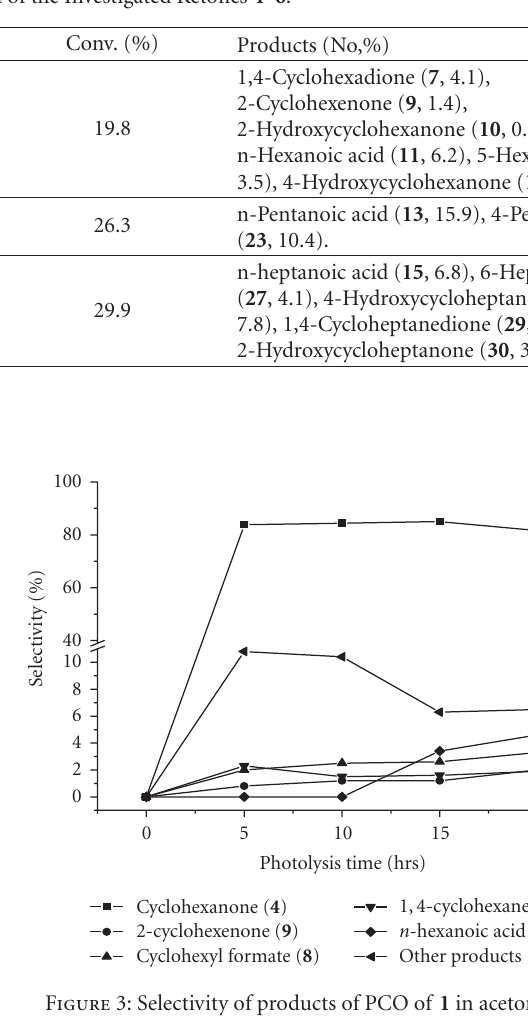
Table 2: Photocatalytic Oxidation of the Investigated Ketones 4 – 6 :